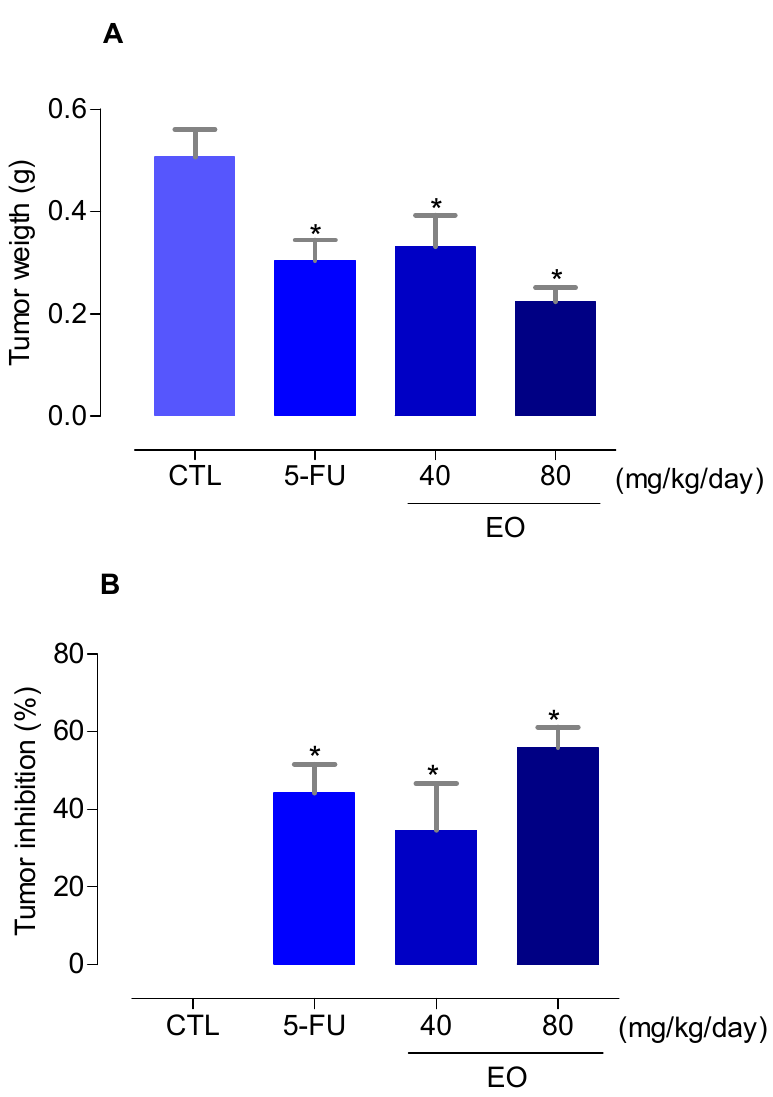
Figure 3. In vivo antitumor activity of the essential oil (EO) from the leaves of Croton matourensis in C.B-17 severe combined immunodeficient (SCID) mice with HepG2 cell xenografts. ( A ) Tumor weight (g) after treatment. ( B ) Tumor inhibition (%) after treatment. Beginning 1 day after tumor implantation, the animals were treated through the intraperitoneal route for 21 consecutive days. The negative control (CTL) was treated with the vehicle (5% DMSO) used for diluting the EO. 5-Fluorouracil (5-FU, 10 mg/kg/day) was used as the positive control. Data are presented as means ± SEM. of 10–20 animals. * P < 0.05 compared to the negative control by ANOVA followed by Bonferroni’s multiple comparison test.